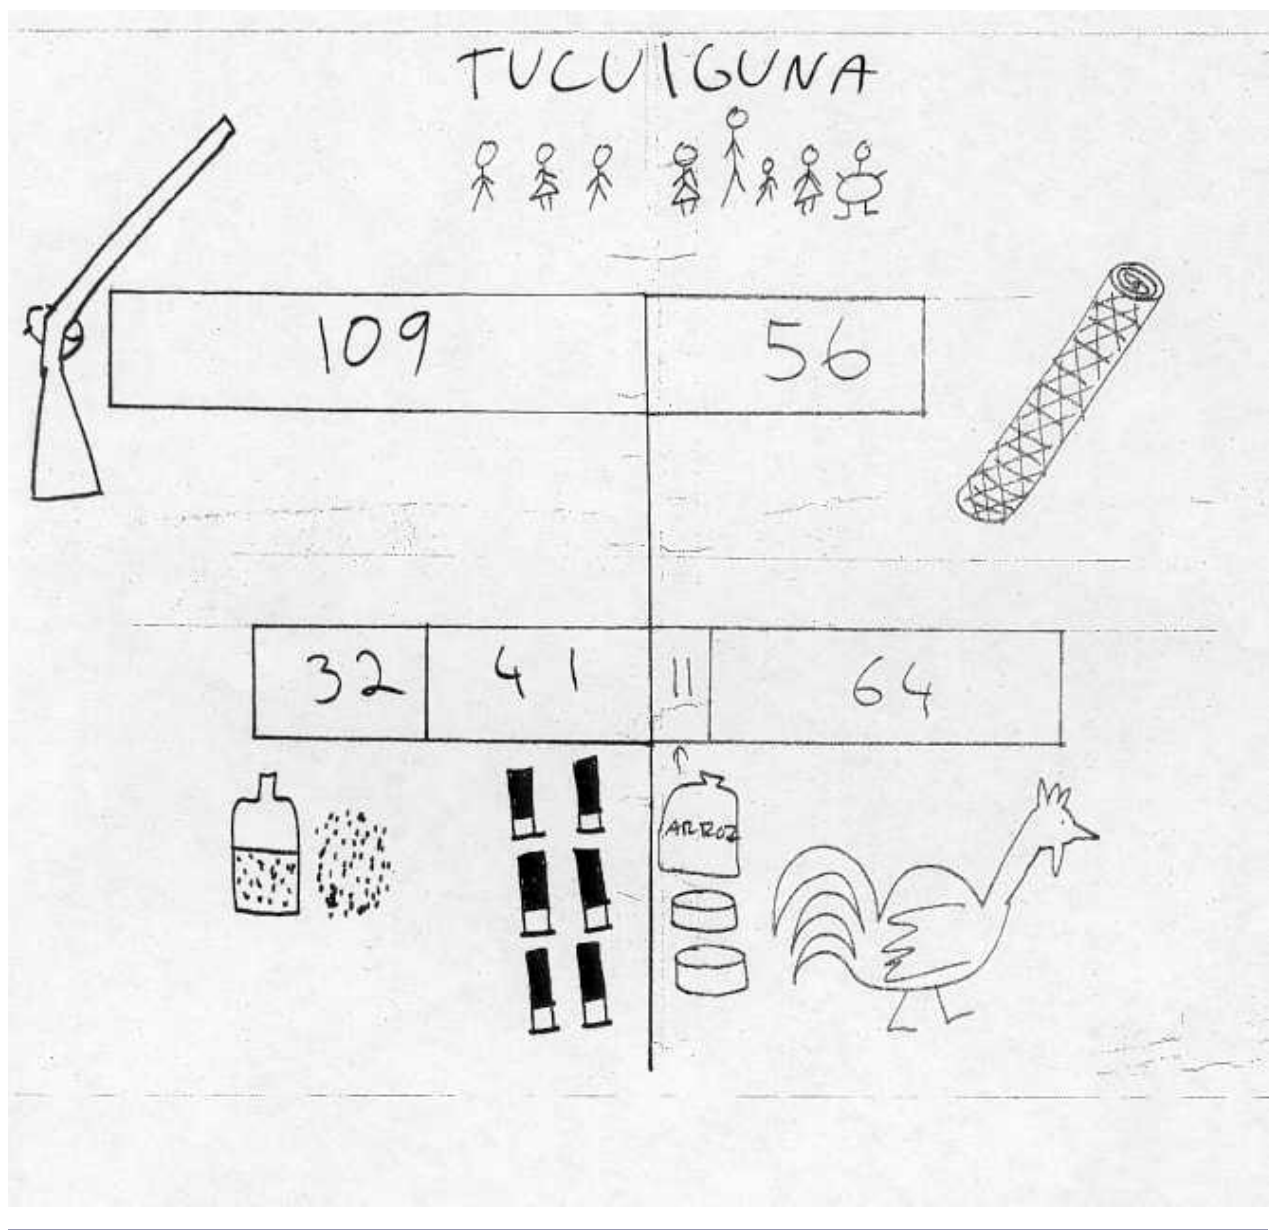
Fig. 2. Overall experimental results. Figs. 2–5 were scanned from posters that were drawn to present the results at workshops in the